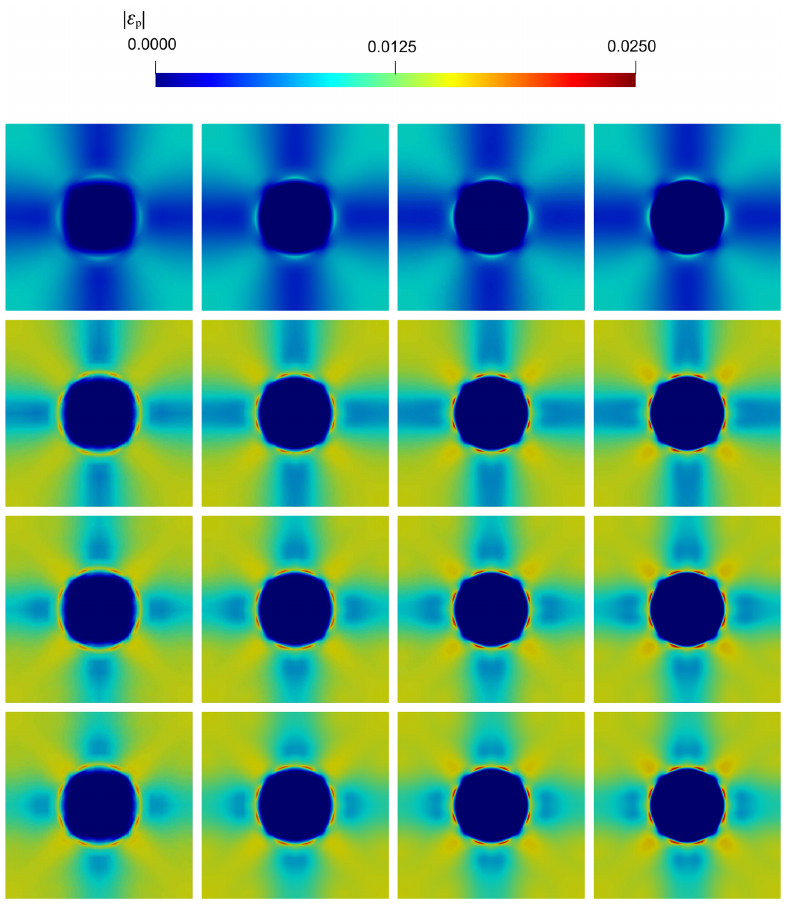
Figure 10: Shear: distribution of plastic strains 𝜀𝜀𝜀 255, 270 and 290